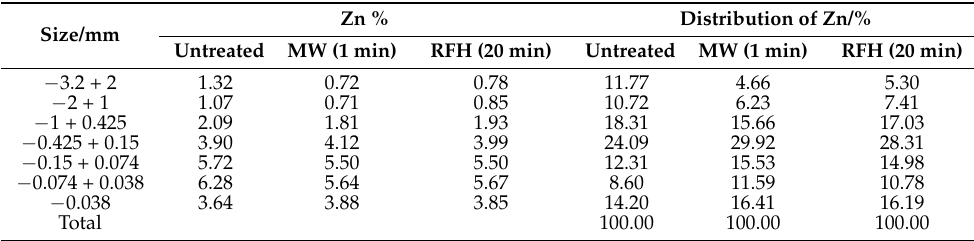
Table 9. Grade and distribution of Zn for each particle size range of the grinding product.